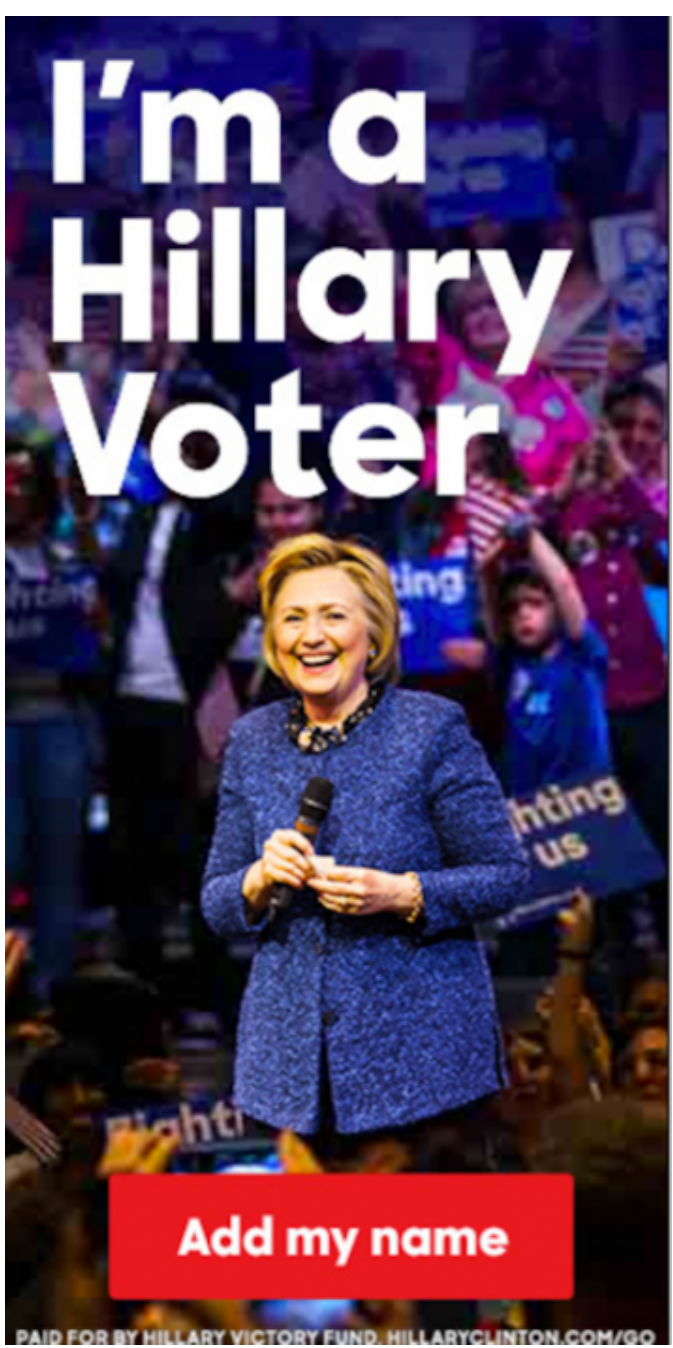
Figure 1: Hillary Clinton digital campaign